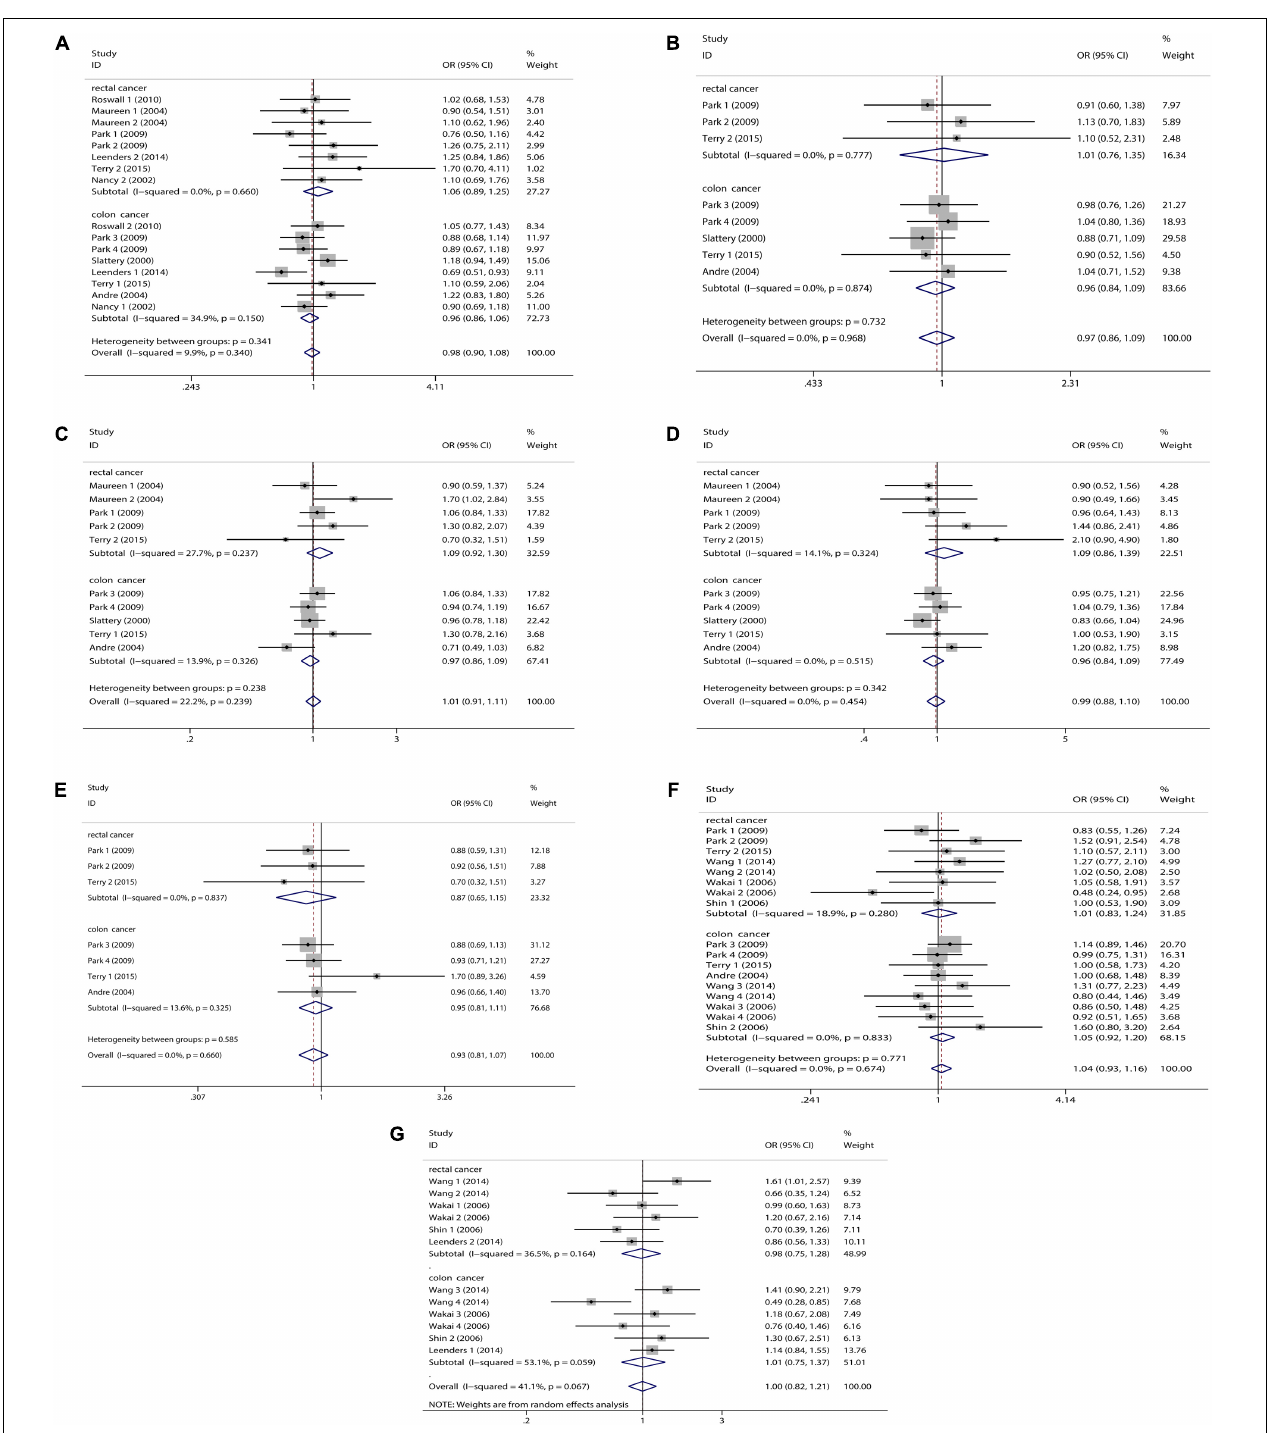
FIGURE 3 | Tumor subgroup analysis of dietary carotenoid and retinol intake and colorectal cancer risk. (A) β -carotene; (B) α -carotene; (C) lycopene; (D) lutein/zeaxanthin; (E) β -Cryptoxanthin; (F) carotenoids; (G) retinol.